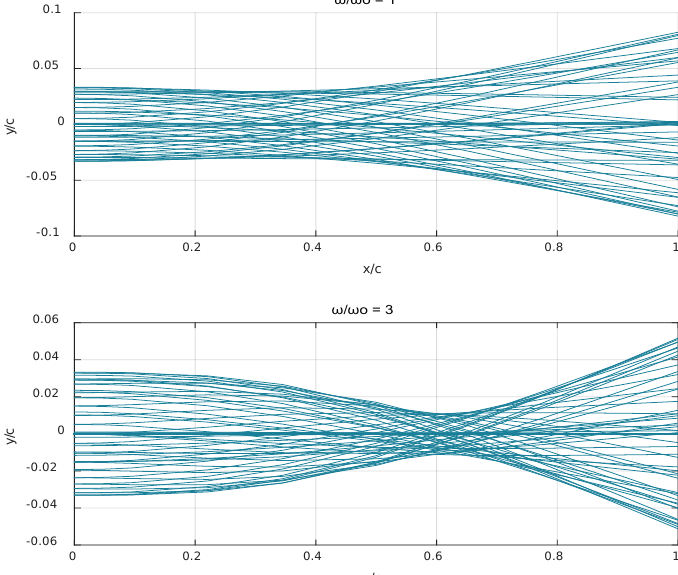
Figure 13. ( a ) Phase lag as a function of the frequency and comparison with experimental data (denoted by black triangles) from [34]. ( b ) Thrust nondimensionalized by the characteristic elastic force, as a function of the frequency.